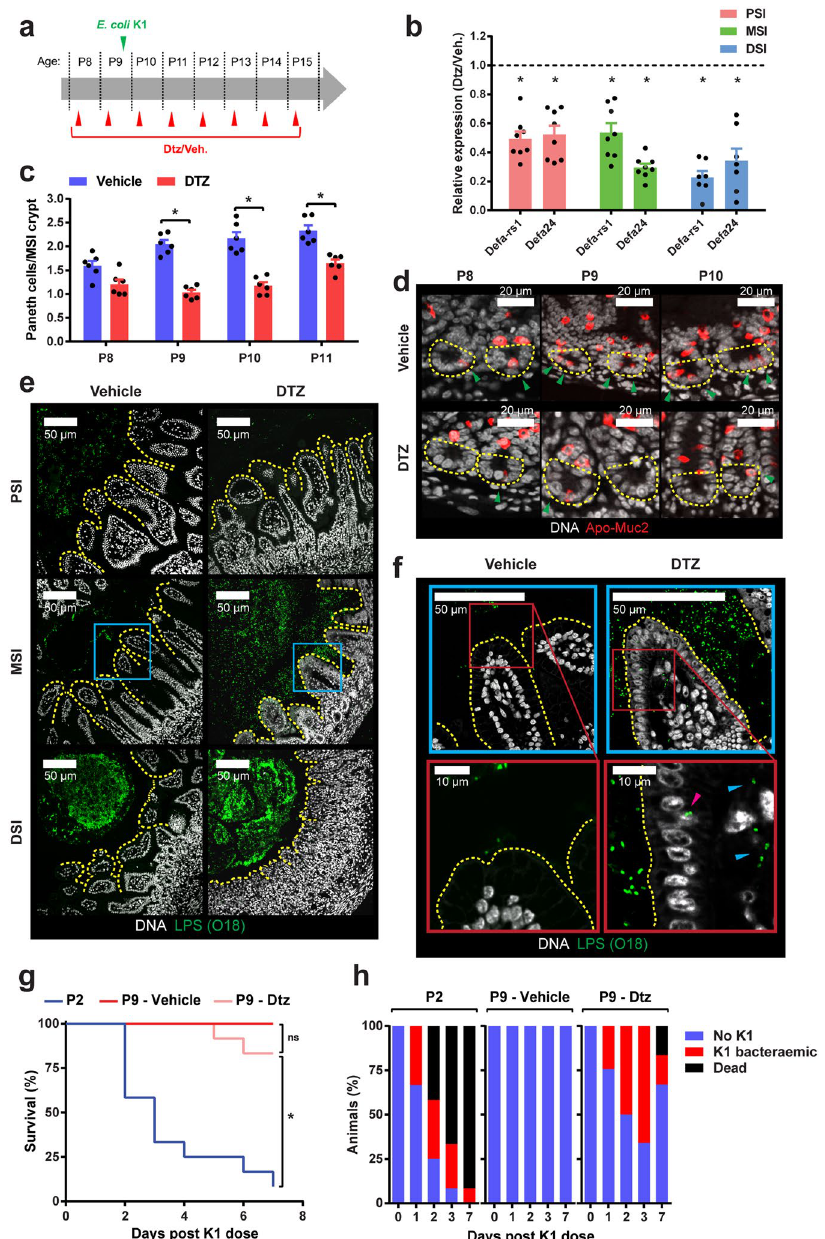
Figure 5. DTZ-mediated suppression of Paneth cell function in infection-resistant neonatal rat pups facilitates E. coli K1 invasion of the MSI. ( a ) Neonatal rats received 40–50 mg/kg DTZ or Li 2 CO 3 buffer (vehicle) by i.p. injection as indicated. Colonization with E. coli A192PP initiated at P9. ( b ) Determination by qRT-PCR of defa-rs1 and defa24 in PSI, MSI and DSI 72 h after initiation of DTZ dosing, relative to values obtained with corresponding tissues from animals dosed with Li 2 CO 3 buffer alone (dashed line); n = 7–8 animals, mean ± SEM (DTZ vs. buffer), * P < 0.05 (Mann-Whitney U ). ( c ) Quantification of Paneth cells in crypts of MSI tissues over period P8-P11. Tissues were removed from rat pups that had been dosed with DTZ or Li 2 CO 3 buffer according to schedule A; n = 6 animals, mean ± SEM, * P < 0.05 (Sidak’s multiple comparison). ( d ) Representative confocal micrographs used to calculate data in C; Methacarn-fixed MSI sections were stained for Apo-Muc2 (red) and DNA (grey); Paneth cells ( ) and crypt base (yellow dashed line) indicated. ( e ) Confocal micrographs of Methacarn-fixed PSI, MSI and DSI sections obtained from pups dosed with DTZ or Li 2 CO 3 buffer 48 h after initiation of colonization with E. coli A192PP at P9; sections stained for O18 LPS (green) and DNA (grey). ( f ) Magnification of stained MSI tissues corresponding to blue boxed regions indicated in E. Intracellular ( ) and translocated ( ) E. coli K1 indicated. Survival ( g ) and presence of E. coli K1 in blood ( h ) of neonatal rat pups colonized with E. coli A192PP. Pups ( n = 12 animals for each group) were fed bacteria at P9 and dosed with DTZ or Li 2 CO 3 buffer according to the dosing schedule ( a ). Response of P2 pups to colonization (no DTZ) is also